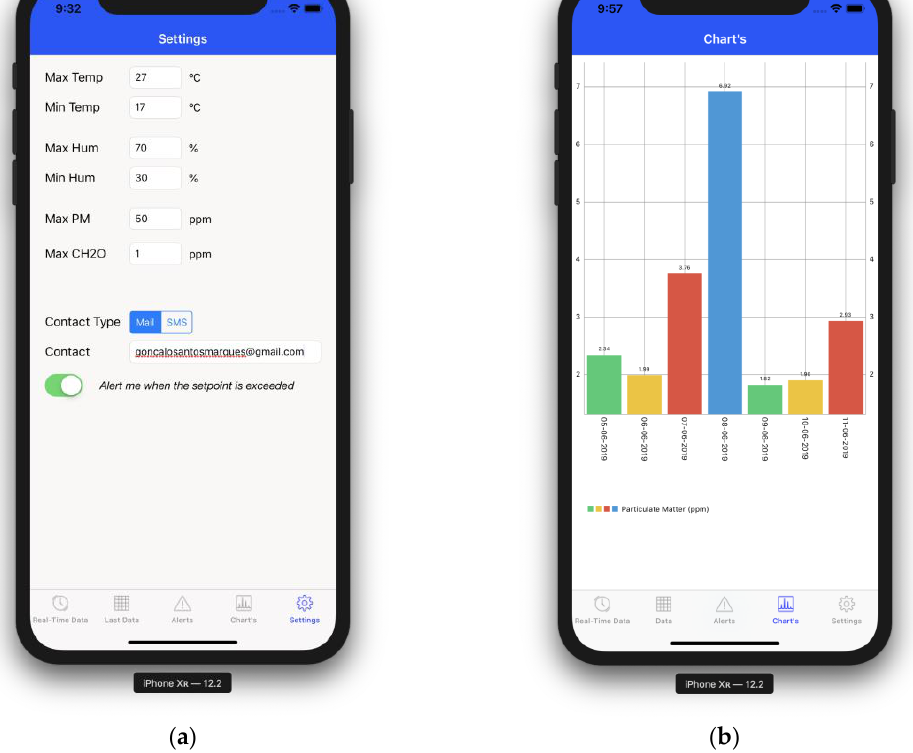
Figure 9. AirPlusMobile main features: ( a ) Alerts configuration; and, ( b ) PM monitoring data—chart representation.